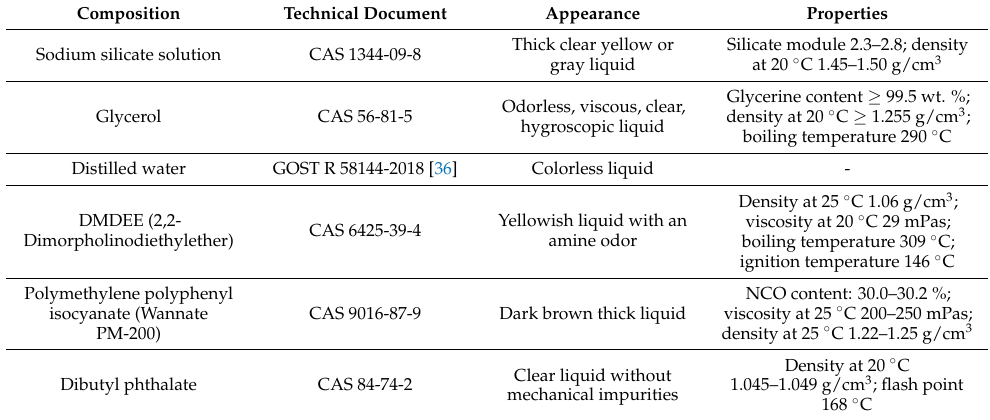
Table 1. Initial materials for silicate resin components.